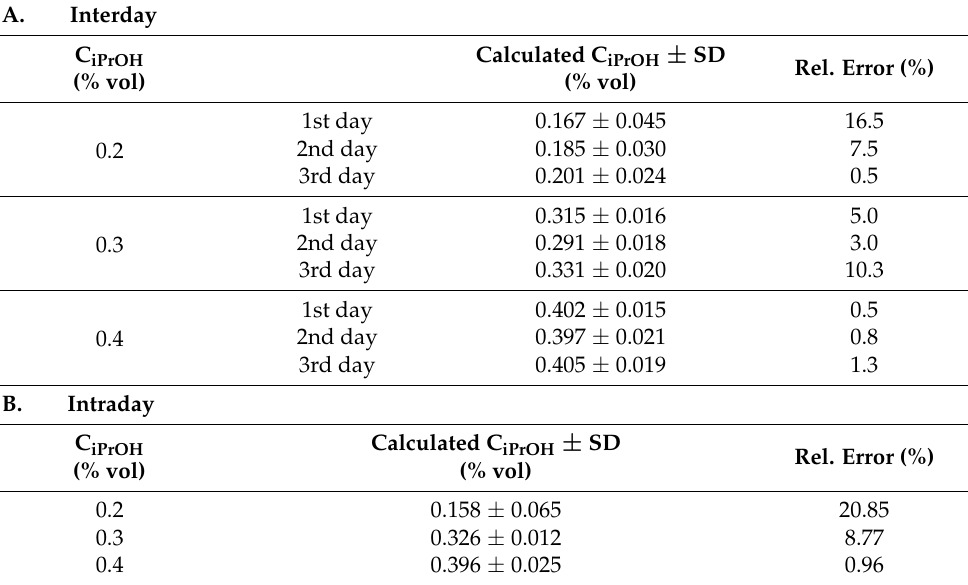
Table 6. Interday and intraday repeatability tests for the isopropanol–whiskey standard